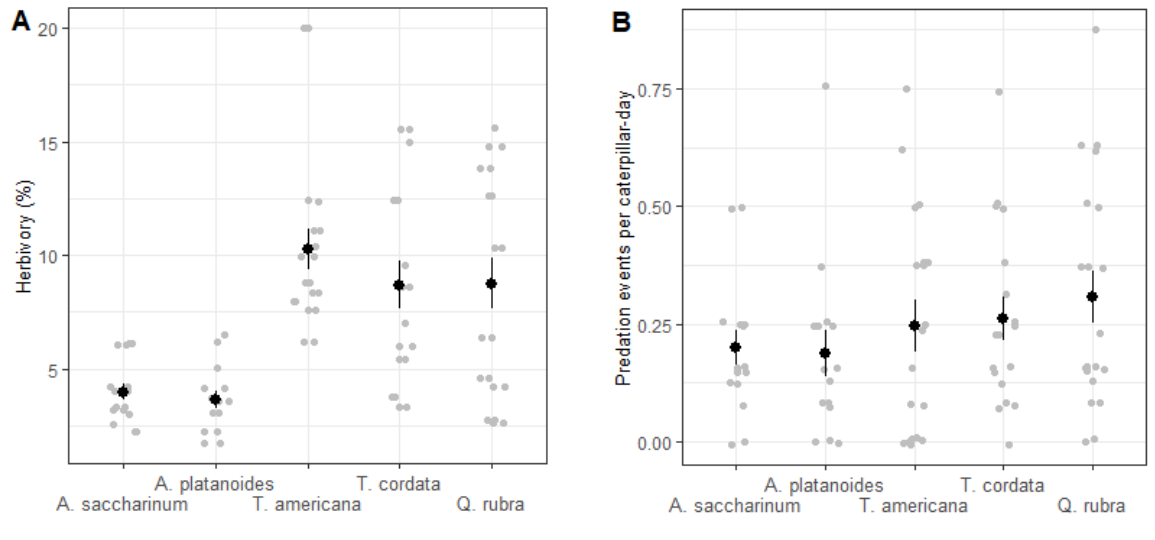
Figure 1. Effect of tree species identity on insect herbivory (A) and predation rate (B). Black dots and solid lines represents mean ± SE calculated on raw data. Herbivory is the percentage of leaf area removed or impacted by herbivores in early summer. Predation events per caterpillar-day is the